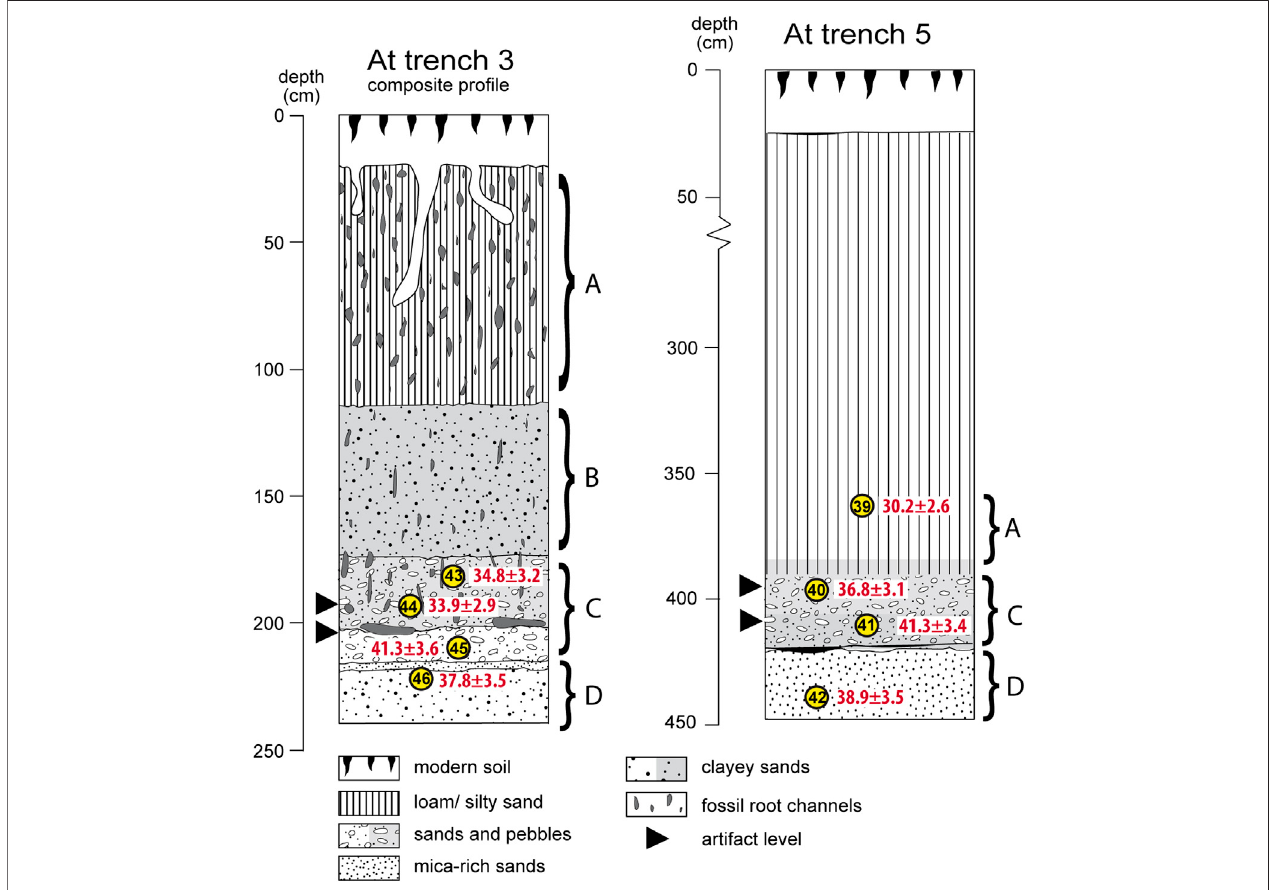
FIGURE2| Pro fi lesketchesshowacompositeofAttrench3Aand3Bontheleftandtrench5ontheright.Theartifact fi ndlevelsareshownwithblacktriangles.For trench3theseincludethefaunalremains.Locationofluminescencesamplesareillustratedandlabeledwiththelasttwodigitsofthelaboratorynumbersinyellowcircles. Luminescence ages are shown in red next to these. Letters A – D indicate the different units as used in Figure 7 .